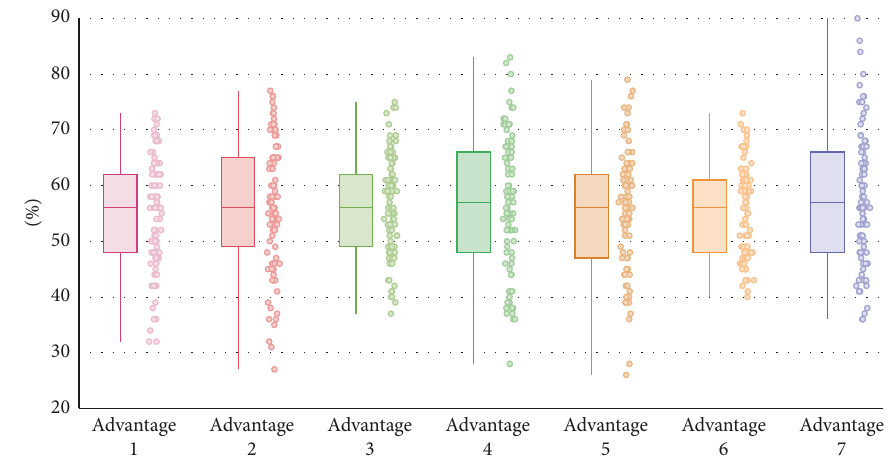
Figure 3: Clustering of input vector neurons with different benefits.